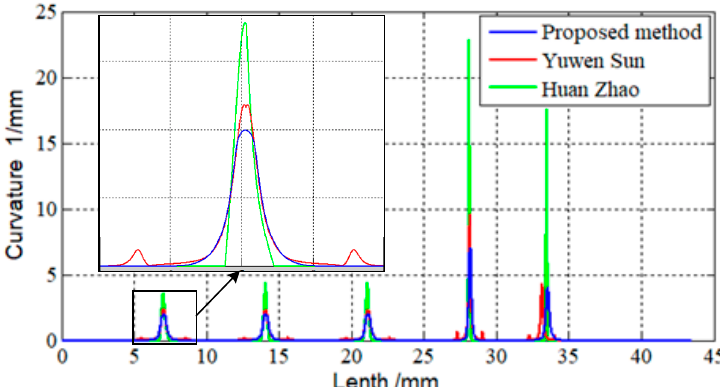
Figure 8. Curvature profiles of 3D tool path.